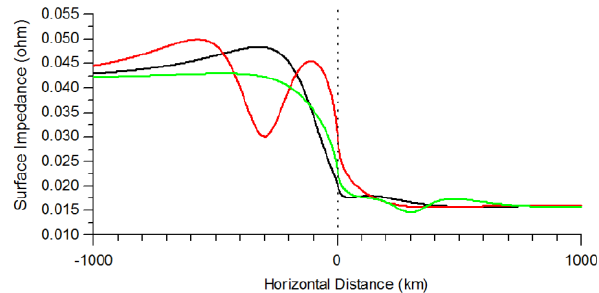
Fig. 12. The surface impedances for the combined models of the three different cases of Figs. 9–11. The black curve is the surface impedance when the line current is located above the interface re- gion. The red curve is the surface impedance when the line current is located at − 300km and the green curve is the surface impedance when the line current is located at 300km. The computations are based on FEM with a period of 300 s.